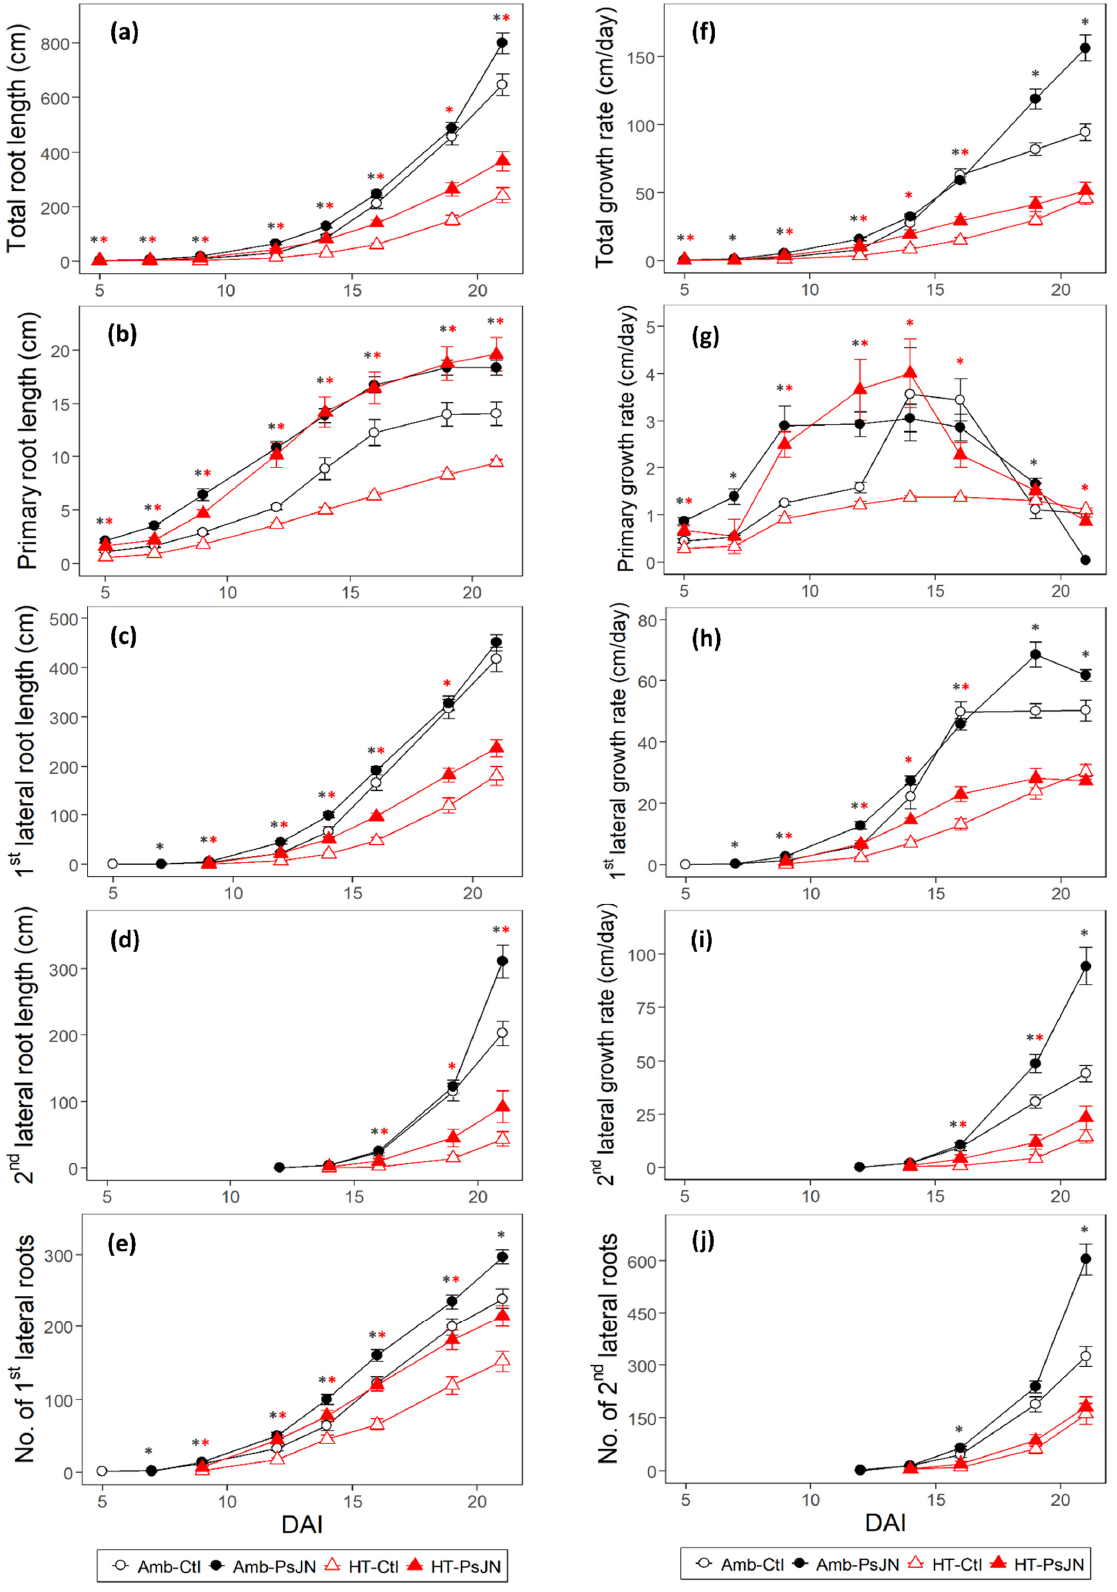
Figure 2. Morphological traits of different root types. Traits were measured in plants with or without bacteria PsJN inoculation under ambient or high temperature conditions from 5 to 21